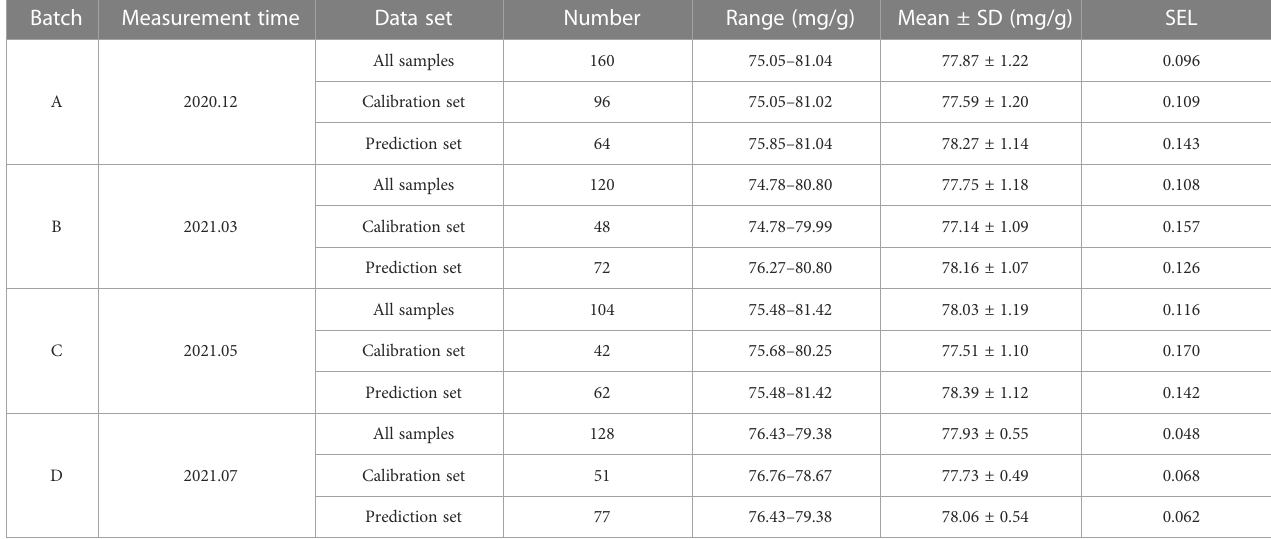
TABLE 1 Statistical data of lignin content (mg/g) of snow pear samples of four batches. Batch Measurement